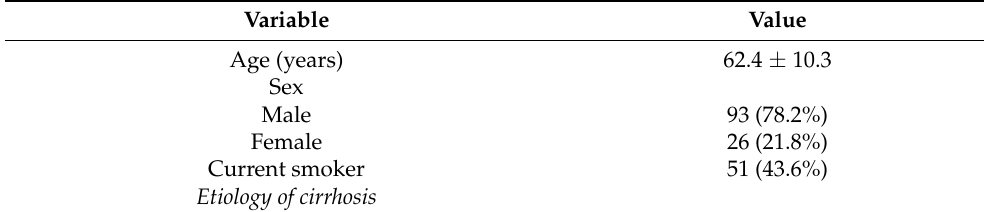
Table 1. Summary of the baseline characteristics for all included patients ( n =